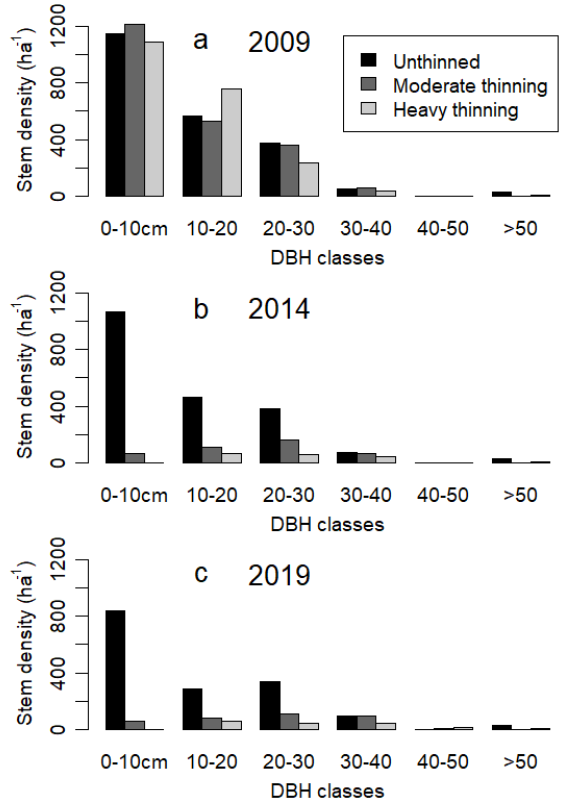
Figure A2. Stem density by diameter at breast height (DBH) classes in centimetres. For 2009, we show the conditions before thinning.